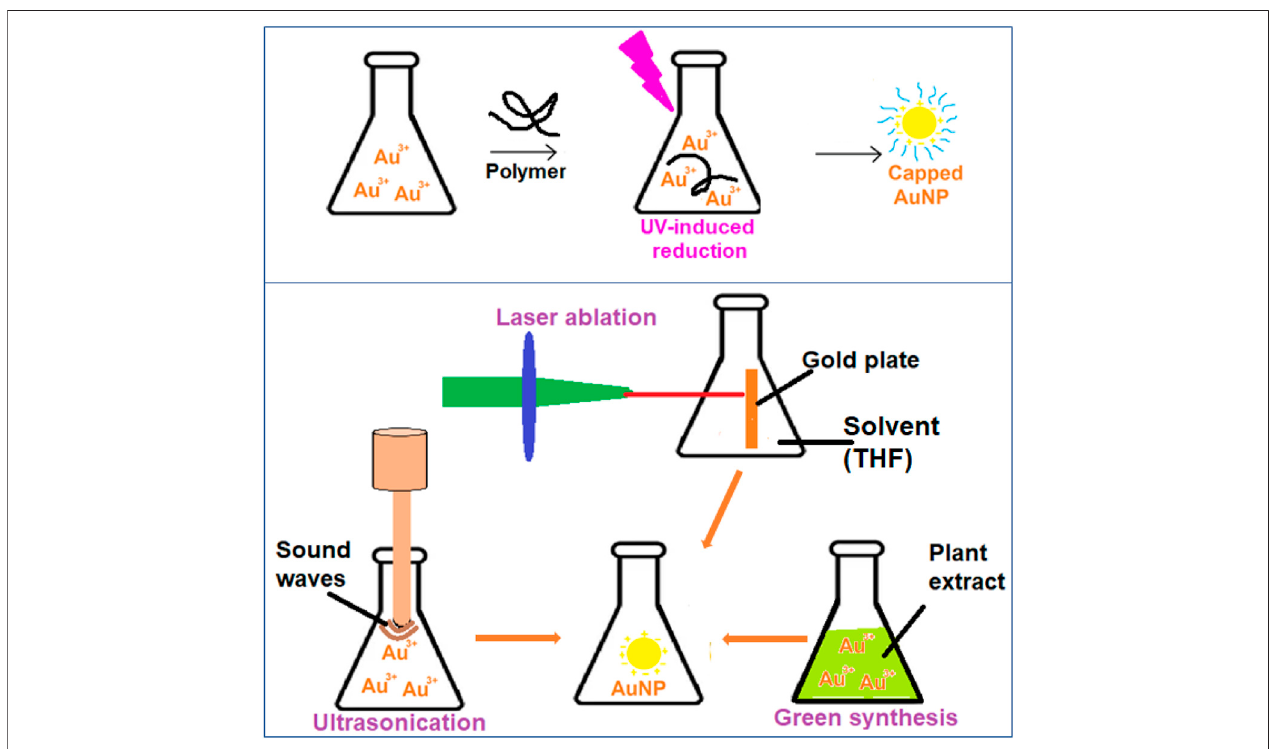
FIGURE 4 | UV-induced, ultrasonication, laser ablation and plant extract based reduction schemes of AuNP synthesis.